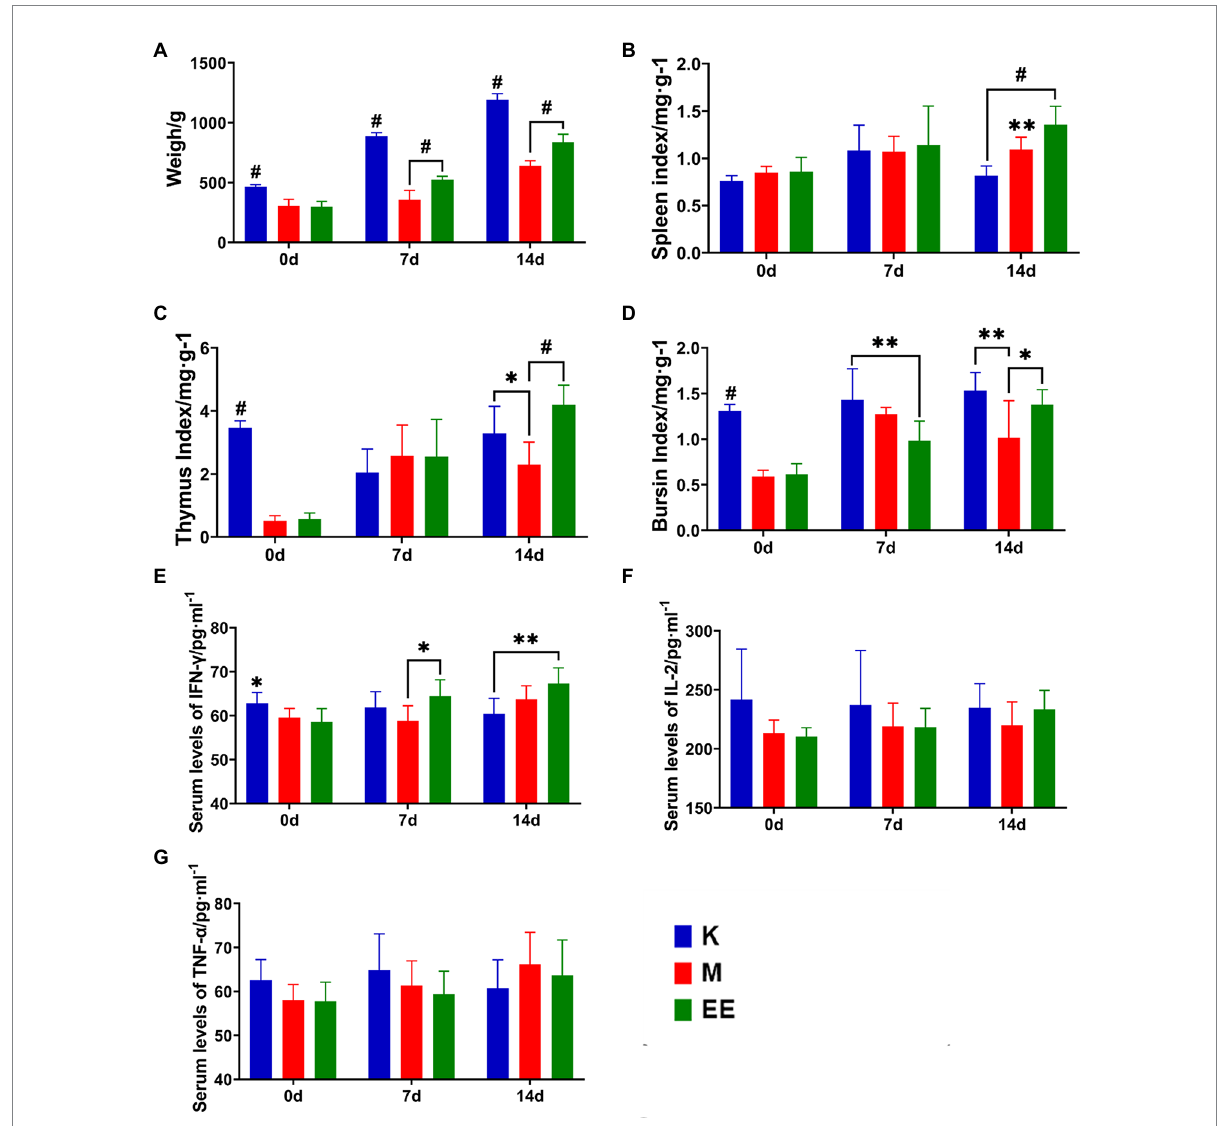
FIGURE 1 Effect of Echinacea on growth performance and immune enhancement. (A) Body weight; (B–D) Immune organ indices; (E–G) Levels of cytokine content in serum. N = 6, p < 0.05 (*), p < 0.01 (**), p < 0.001 (#).